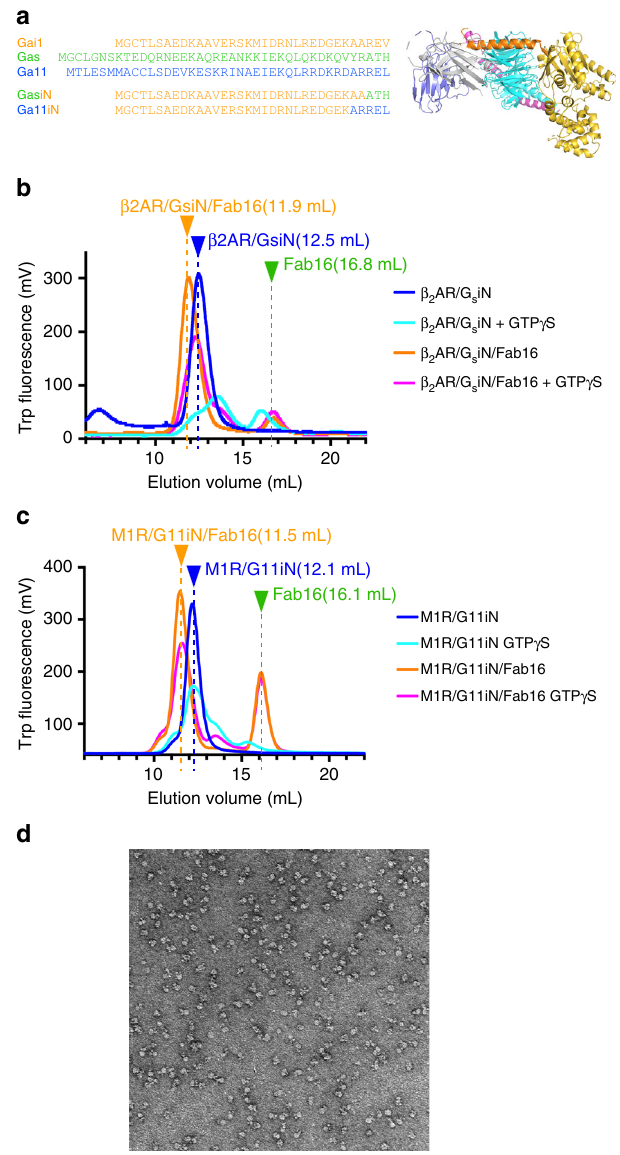
Fig. 5 Generation of chimeric G-proteins. a Alignment of the α N helix of the G-protein subfamilies and the sequence of the chimeric G α subunits. Transferred region from G α i1 in each chimera is colored in